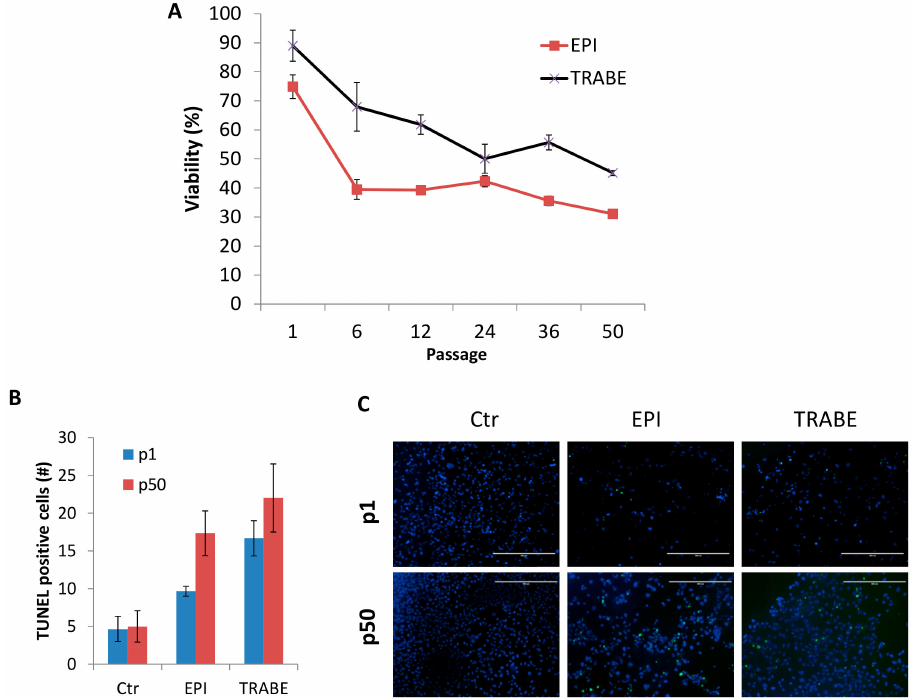
Figure 5. Sensitivity of primary culture and IM-MFS-1 cell line to chemotherapy treatments during the culture period. Survival percentage of IM-MFS-1 cells at different passages treated with epirubicin (EPI) and trabectedin (TRABE). All treatments reduced cell viability at each subsequent passage until a plateau was reached. Treatments were compared with the control (Ctr) conditions at each passage ( A ). Number of TUNEL-positive cells in primary culture (p1) and IM-MFS-1 and cell line at p50. Data were analyzed with Image J software (NIH Image, Bethesda, MD, USA). ( B ) TUNEL staining of primary culture (p1) and IM-MFS-1 cell line at passage 50 (p50) for treated and untreated (Ctr) conditions. Green, TUNEL-positive cells; blue, nuclei counterstained with DAPI ( C